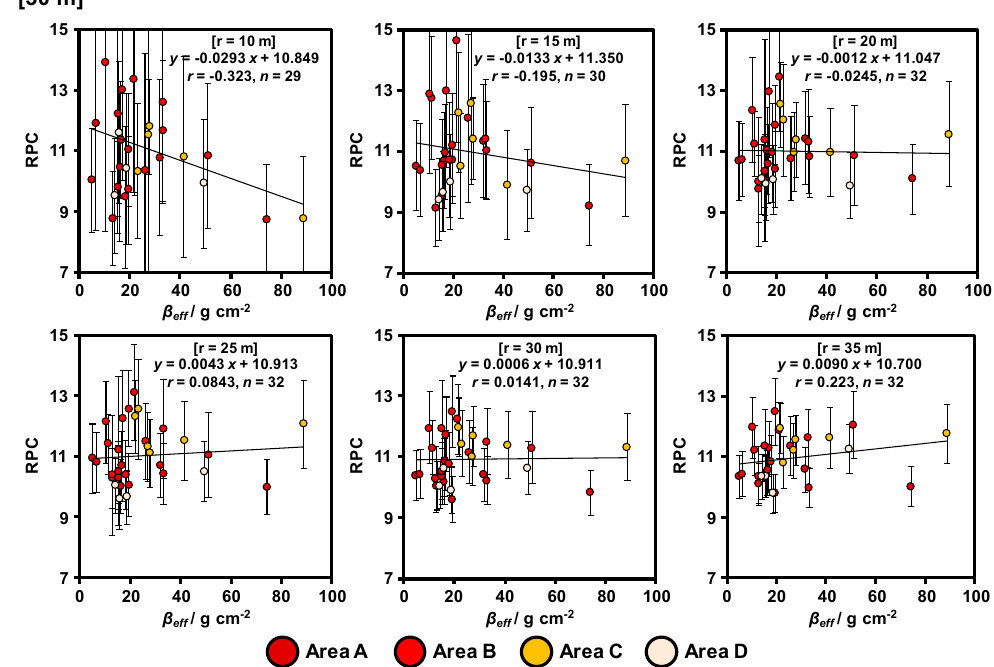
Figure 9. Relationship between RPC at 30 m agl. and β eff with different selected ranges based on soil sampling